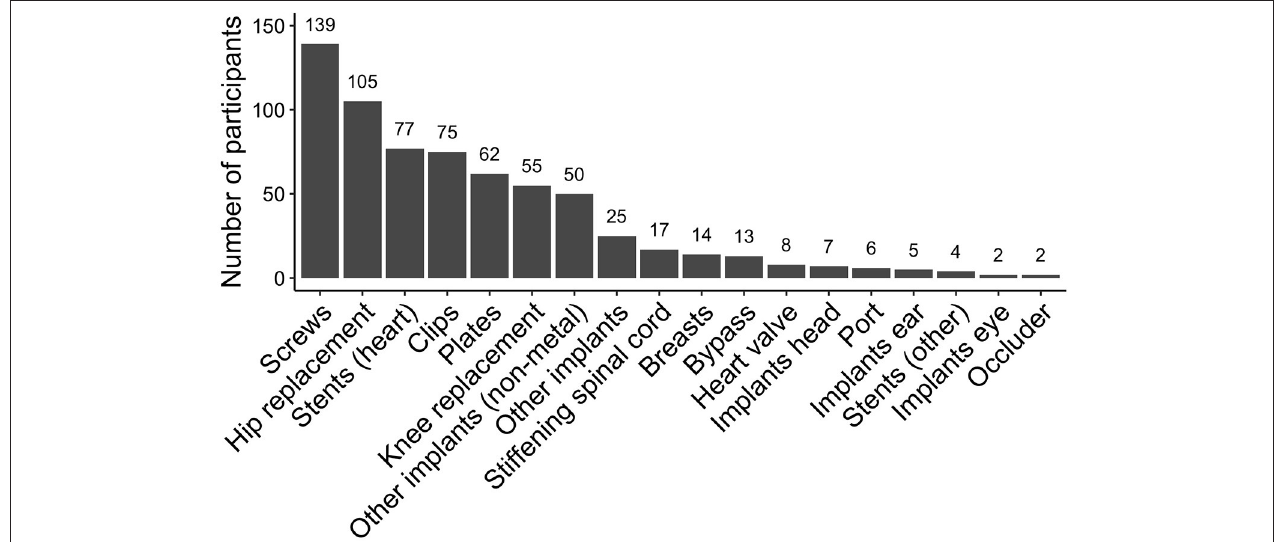
FIGURE 2 | Frequency of eligible medical implants that were scanned at 3T in the Rhineland Study. Participants could have multiple plates or screws, these were each counted as one implant . Other implants included: wire cerclage, threads made from titanium, patches made from Teflon, urinary tract implants, broken dental files. Other implants (non-metal) included: hernia mesh, neobladder, artificial bone mass, gastric